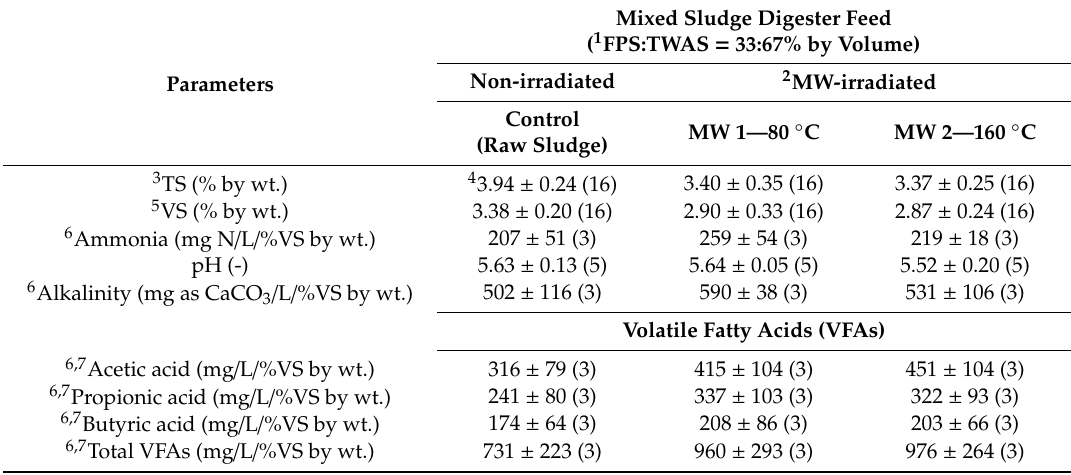
Table 1. Mixed sludge feed characteristics for bench-scale anaerobic digesters.